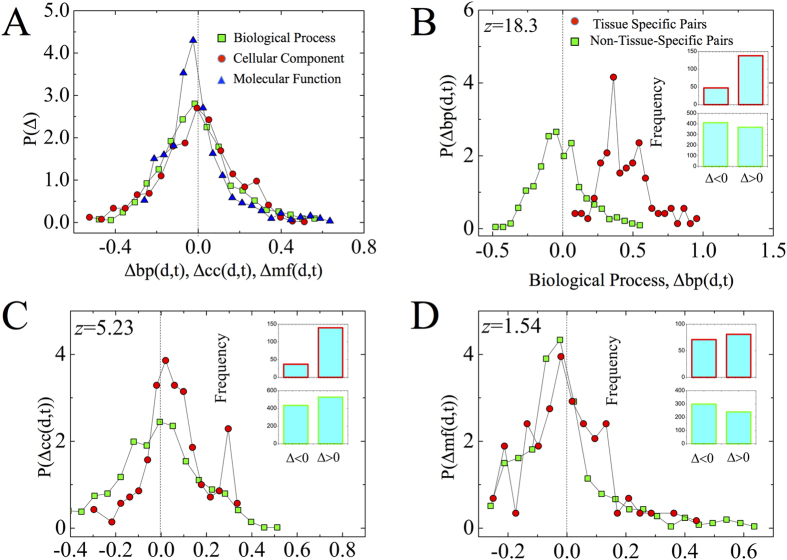
Functional similarity of tissue-specific disease genes.(A–D), Distributions of changes in GO similarities: (A), The distributions of Δbp(d, t), Δcc(d, t), and Δmf(d, t) obtained for all disease-tissue pairs. Measured mean similarity values are, respectively, M(Δbp) = 7.6 × 10−3, M(Δcc) = 0.034, and M(Δmf) = −6.3 × 10−3. (B), Δbp(d, t), (C), Δcc(d, t), and (D) Δmf(d, t) for linked disease-tissue pairs (red circles) and non-linked disease-tissue pairs (green squares). The insets in panels (B–D) compare the total number of Δ > 0 cases with the total number of Δ < 0 cases. Listed z-scores are the results of the Mann-Whitney U test applied to the comparison of GO similarities of linked disease-tissue pairs and non-linked disease tissue pairs.